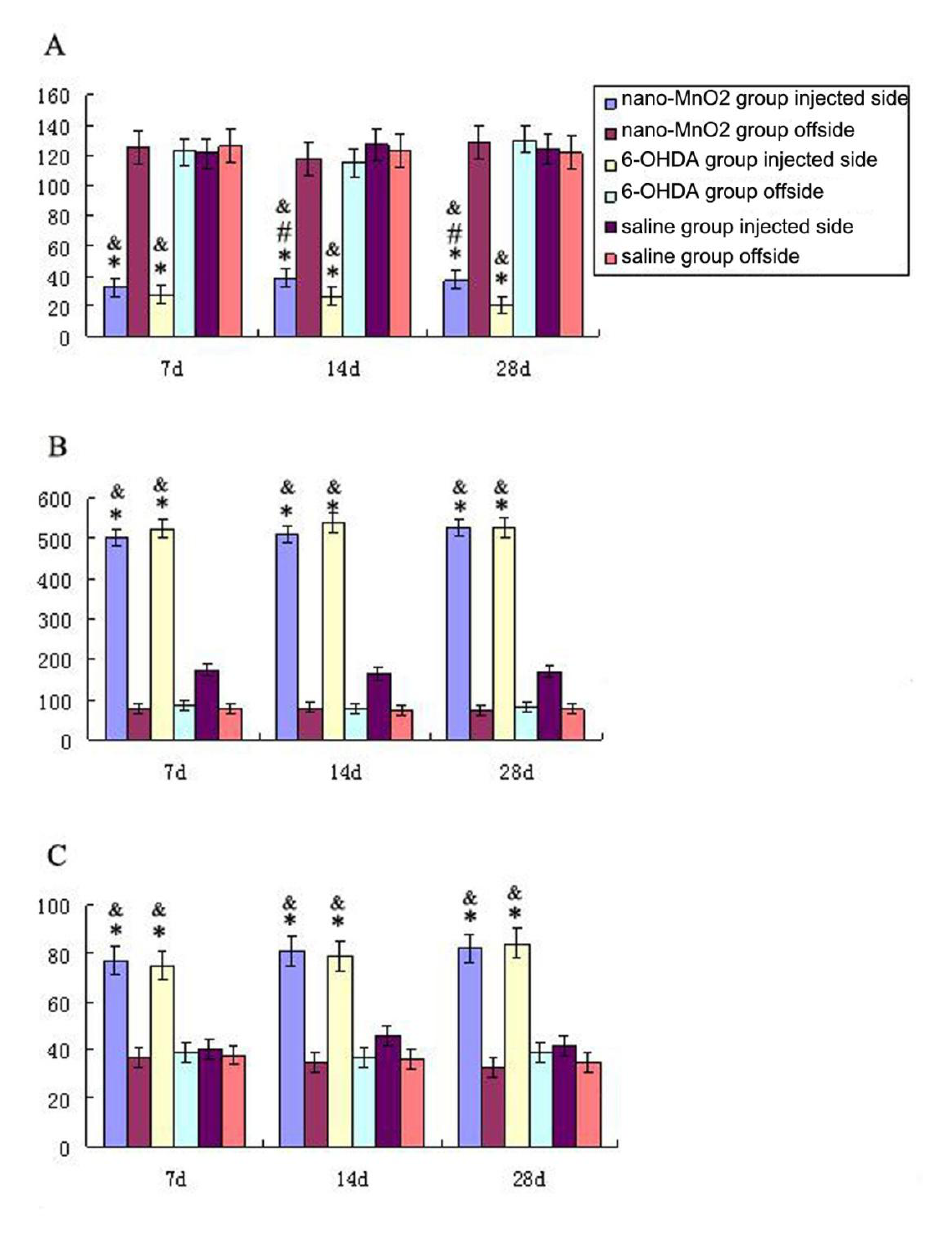
Figure 4. Number of immunostained positive cells in both sides of rat brain. ( A ) TH-positive cells, ( B ) GFAP-positive cells; and ( C ) iNOS-positive cells (* p < 0.05 compared with saline injected side, # p < 0.05 compared with 6-OHDA injected side, & p < 0.05 compared with